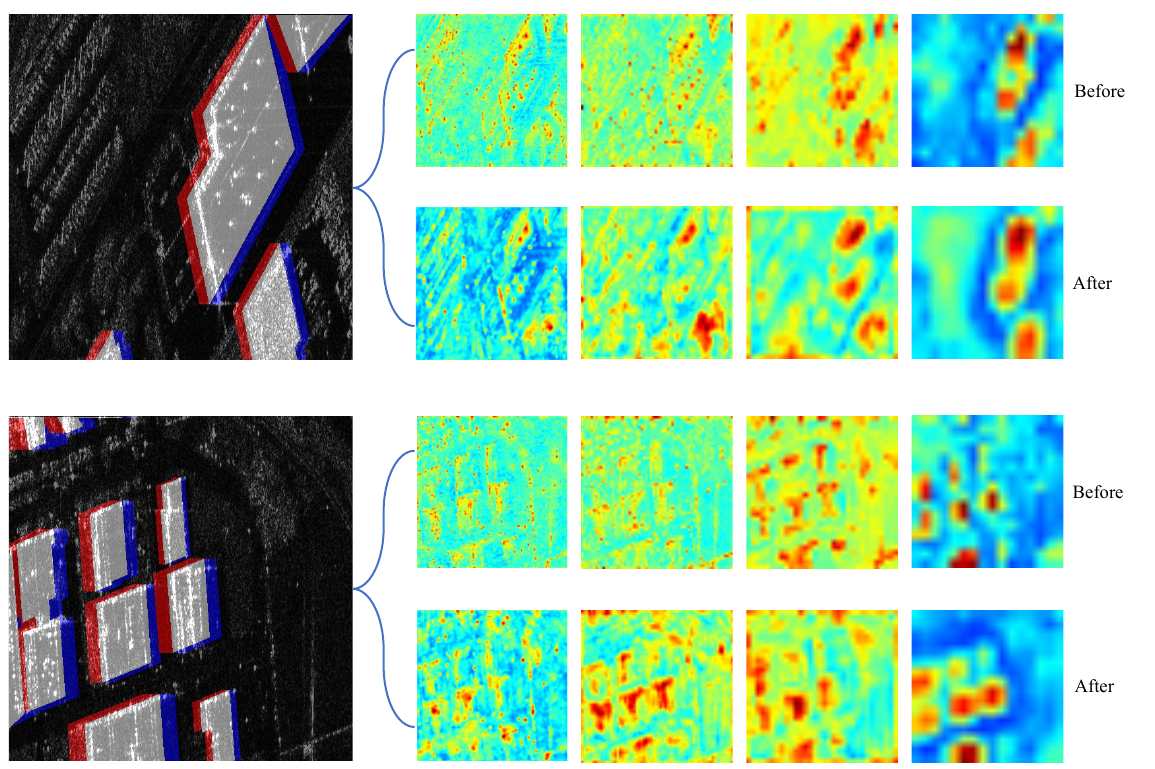
Figure 11. Visualization results of features before and after the LFCA